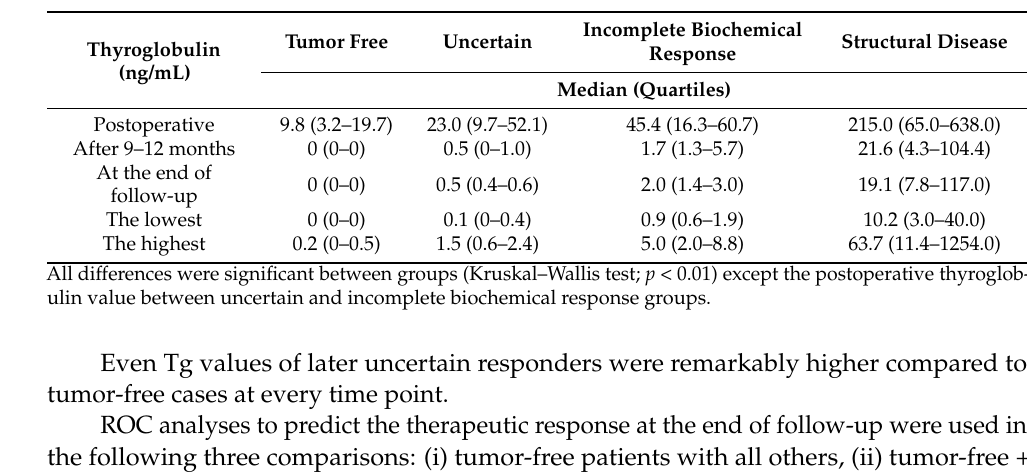
Table 4. Thyroglobulin values according to therapeutic responses.